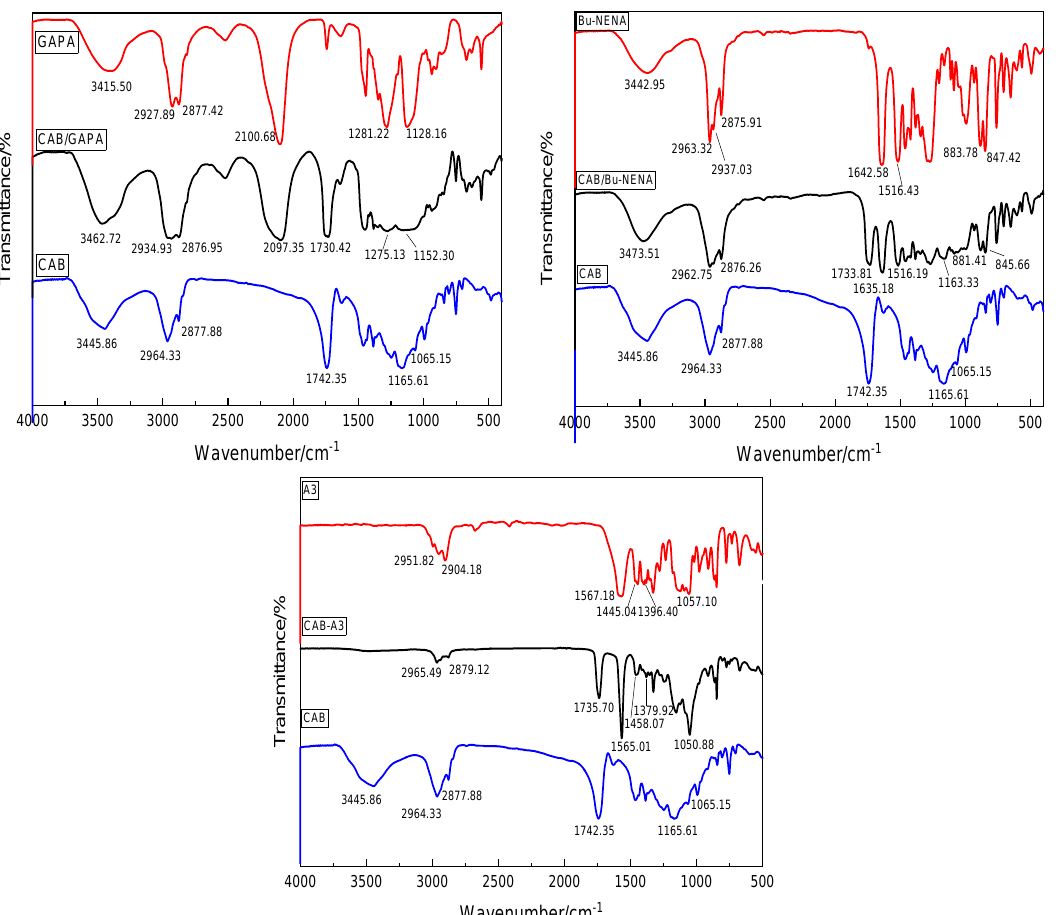
Figure 4. FT-IR spectra of CAB, plasticizer and CAB/plasticizer systems.